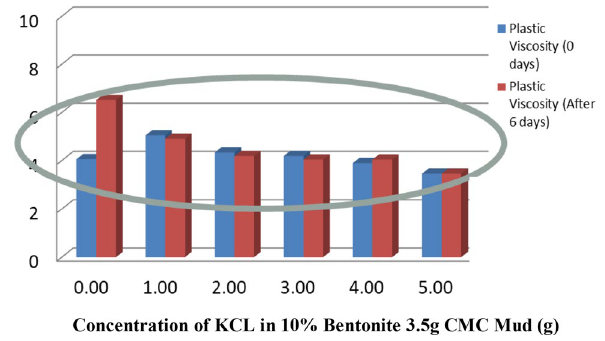
Fig. 12 Effect of KCl on plastic viscosity of CMC–bentonite mud in accordance with